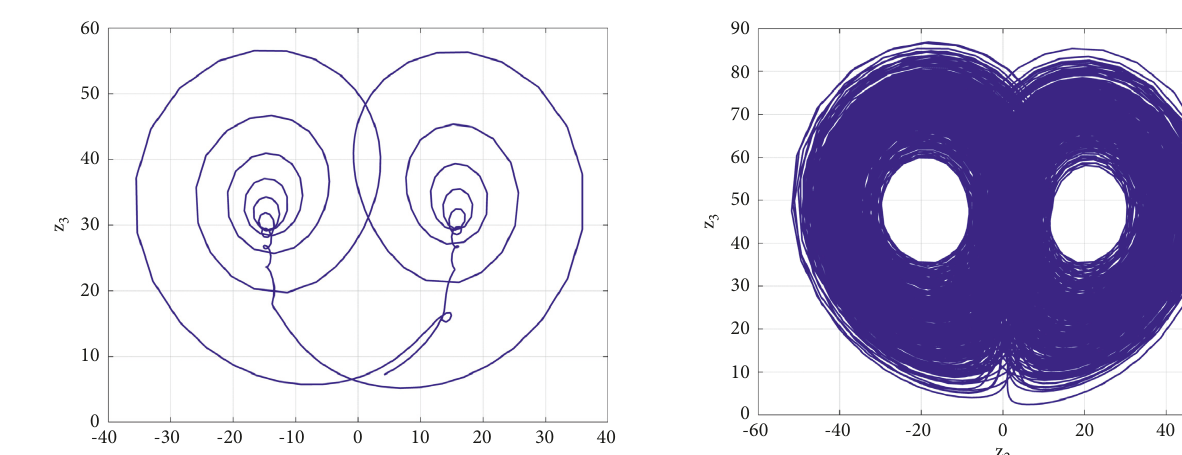
Figure 16: A periodic attractor of the 4-D system (1) when c � 30 . 5 and ( a,b, d ) � ( 25 , 8 , 6 ) .